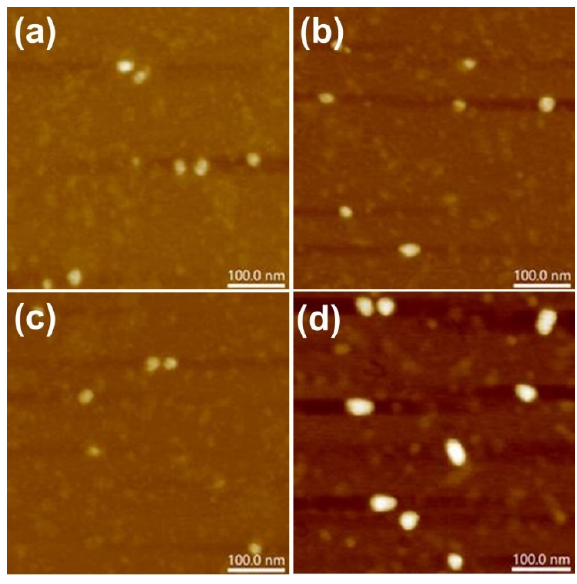
Figure 7. AFM images of ( a ) PeptoidCB 43/5 -2, ( b ) PeptoidCB 43/5 -2/BSA, ( c ) PeptoidQA 43/5 -2, and ( d ) PeptoidQA 43/5 -2/BSA.